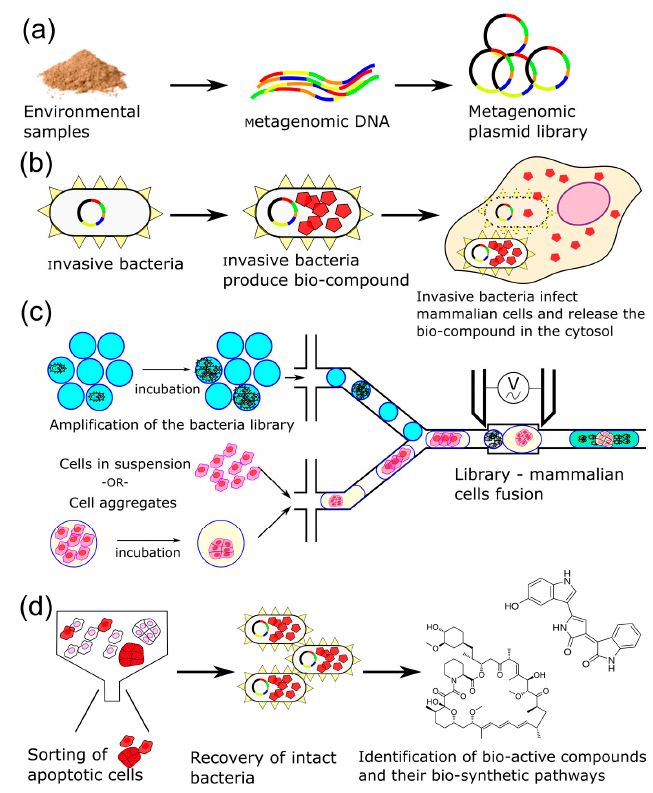
Figure 1. Overall strategy to mine natural resources for pro-apoptotic bioproducts. ( a ) Generation of metagenomic libraries from environmental samples; ( b ) Delivery of bioproducts by invasive bacteria into mammalian cells. Invasive E. coli producing a natural compound are taken up by mammalian cells and are lysed in phagosomes. The released natural product (red pentagon) is then free to interact with its targets; ( c ) Droplet microfluidics is critical by enabling: (1) the unbiased amplification of the metagenomic library by limited encapsulation of a single bacterium, (2) the controlled generation of cell aggregates, and (3) the maintaining of clonality of the entire process; ( d ) After treatment, apoptotic cells or aggregates are sorted, pro-apoptotic invasive bacteria are recovered and their plasmid isolated. In parallel, bacteria can be analyzed by mass spectrometry to identify the bio-active compounds.